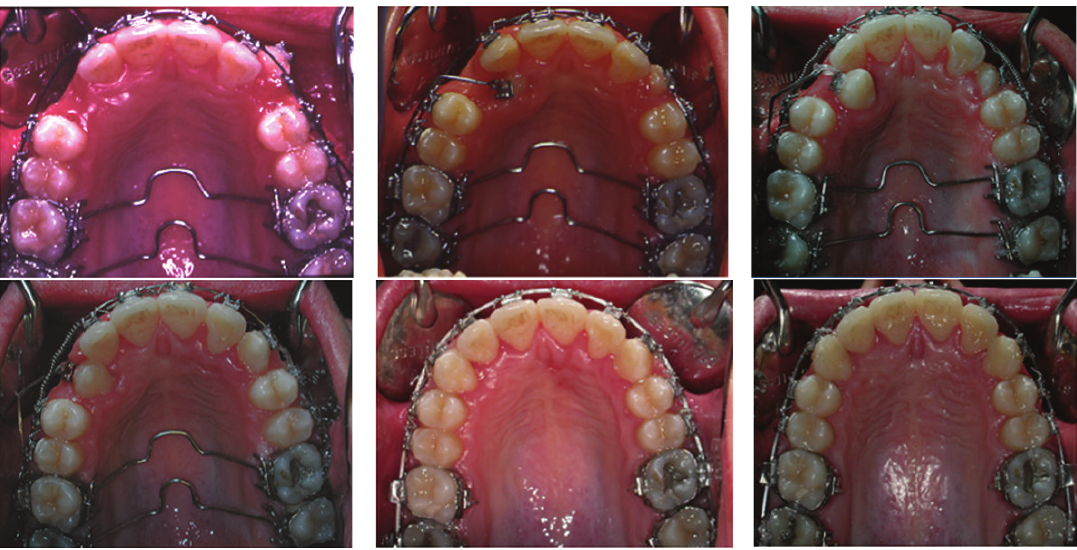
Figure 6: From left to right, progressive recovery of the maxillary canines.